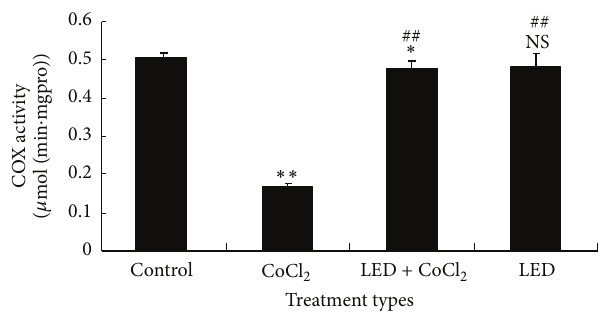
Figure 4: Effect of 25 mW/cm 2 808 nm LED light pretreatment on COX activity. After cultured neuron cells being digested and collected, mitochondria isolation assay was added. 15 minutes later, cells were homogenized. After being centrifuged (600 g) for 10 min- utes, supernatant was collected. After being centrifuged (11000g) for 10minutes, theprecipitation was collected. Mitochondrial lysatewas added to obtain the samples. Then COX was measured. Data are Means ± SEM. ∗∗ ( 𝑃 < 0.01 ) and ∗ ( 𝑃 < 0.05 ) mean compared with control group; ## ( 𝑃 < 0.01 ) and # ( 𝑃 < 0.05 ) mean compared with 100 𝜇 M/L CoCl 2 group.